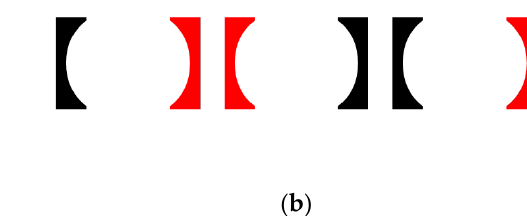
of similarity, ( b ) Law of similarity is stronger than law of closure. similarity, ( b ) Law of similarity is stronger than law of